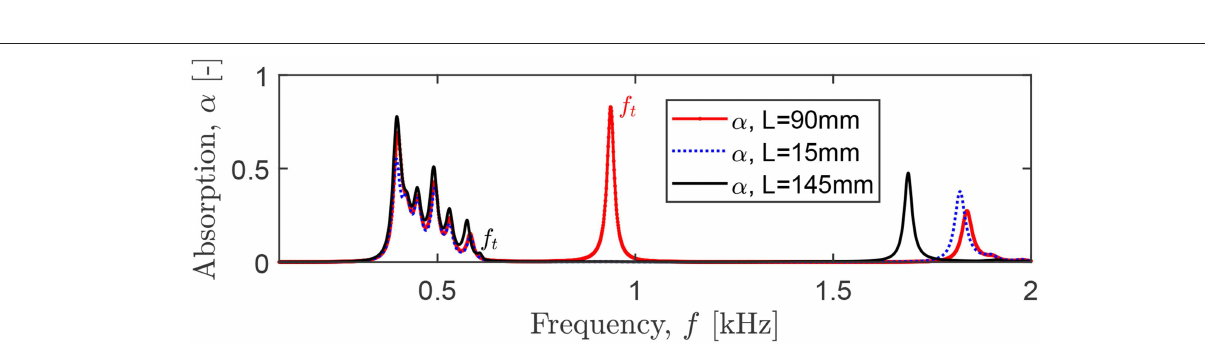
FIGURE 5 | Transformation steps to replicate the “ grozovik "-inspired design (see the symbol 7 in Figure 1A ), including (A) coiling the HR cavities, (B) rotation of the HRs along the central axis of the tube, (C) shift of the HRs toward an open end of the tube.